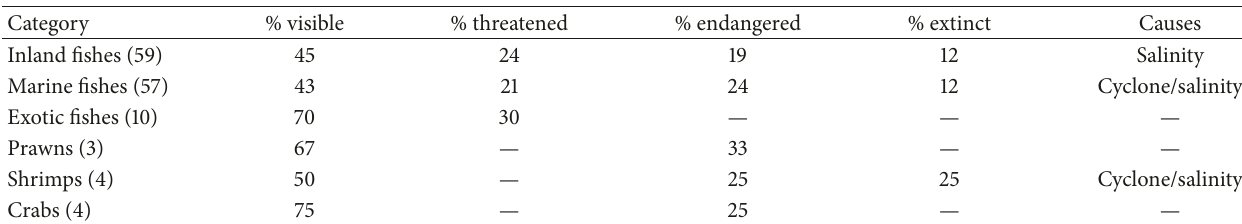
Table 11: Present status of recorded visible, threatened, endangered, and extinct fish species at Kalapara coastal